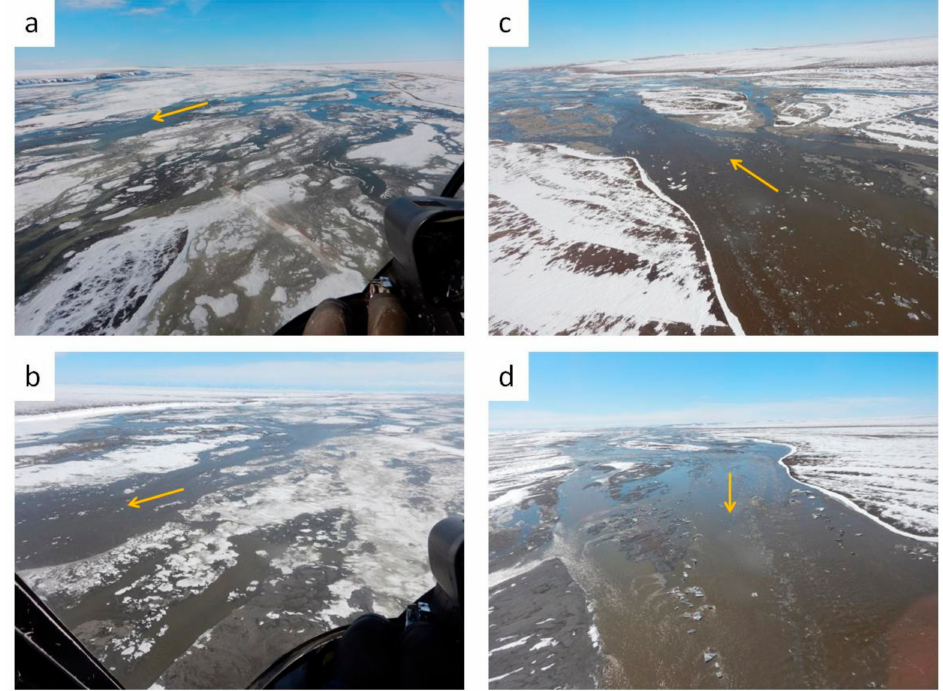
Figure 1. Sequential aerial views of the Sagavanirktok River during breakup 2017: ( a ) multiple channels flowing during the early stages of breakup; ( b ) flow complexity increases as breakup progresses; ( c ) extensive ice floating along the well-defined channels; and ( d ) banks near the road system still covered by snow and ice, making river access impossible. Arrows indicate flow